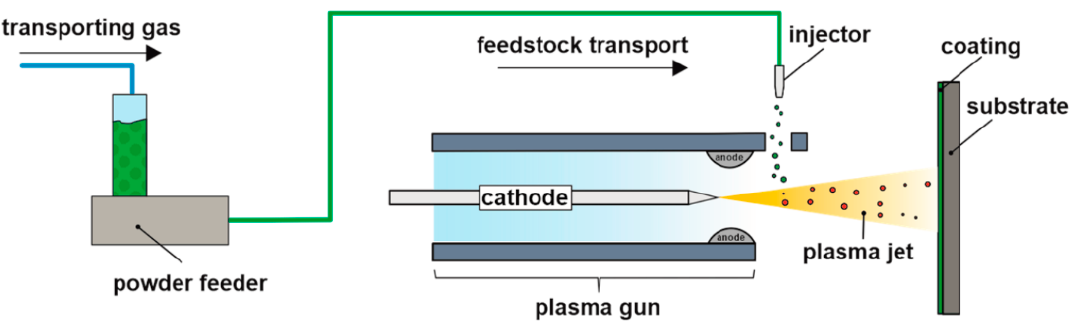
Figure 2. Schematic representation of atmospheric plasma spraying [36].